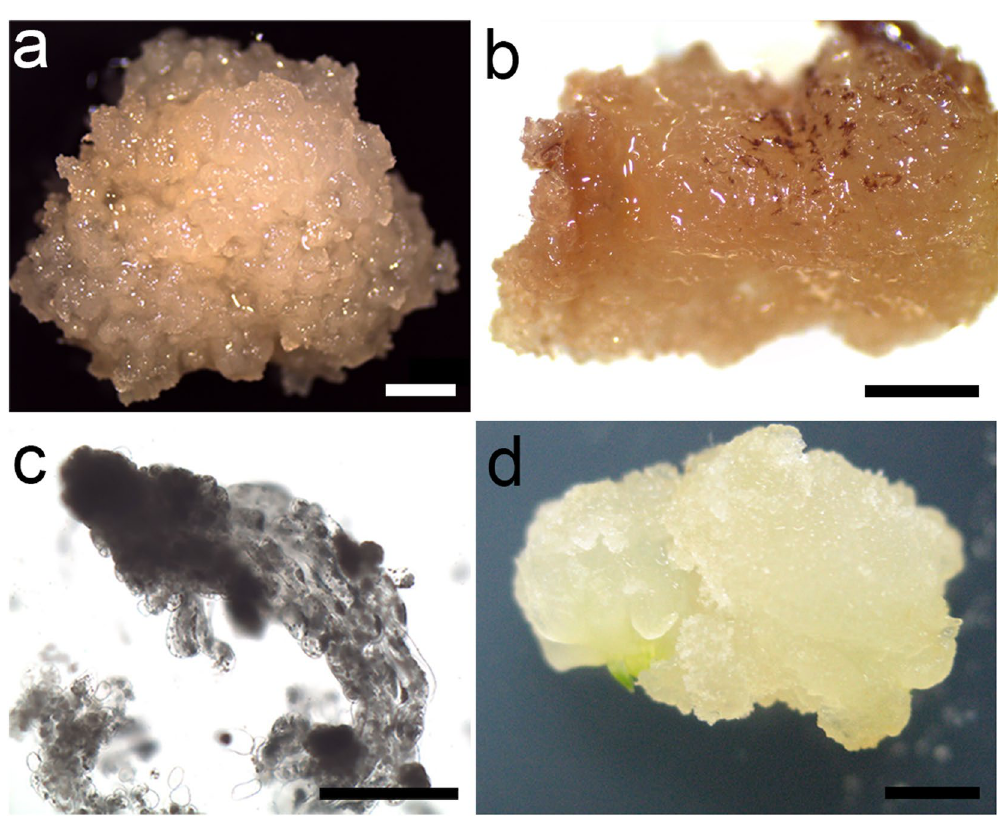
Figure 5. Effects of proliferation media PM1 and PM2 on cultures proliferation. ( a ) Further development of embryogenic callus in proliferation medium PM1. ( b ) Cultures mainly induced by cleavage polyembryony embryos dedifferentiated into soft and easy browning callus in proliferation medium PM2. ( c ) Embryogenic suspensor mass structures of the embryogenic callus observed under a microscope; these structures consisted of clusters of small meristematic cells with dense cytoplasm forming emerging embryonal heads with attached elongated suspensor cells. ( d ) Cultures mainly induced by precotyledon embryos dedifferentiated into hard and difficult to proliferate callus in medium PM2. ( a , b , d ) bars 1 mm, ( c ) bar 100 μ